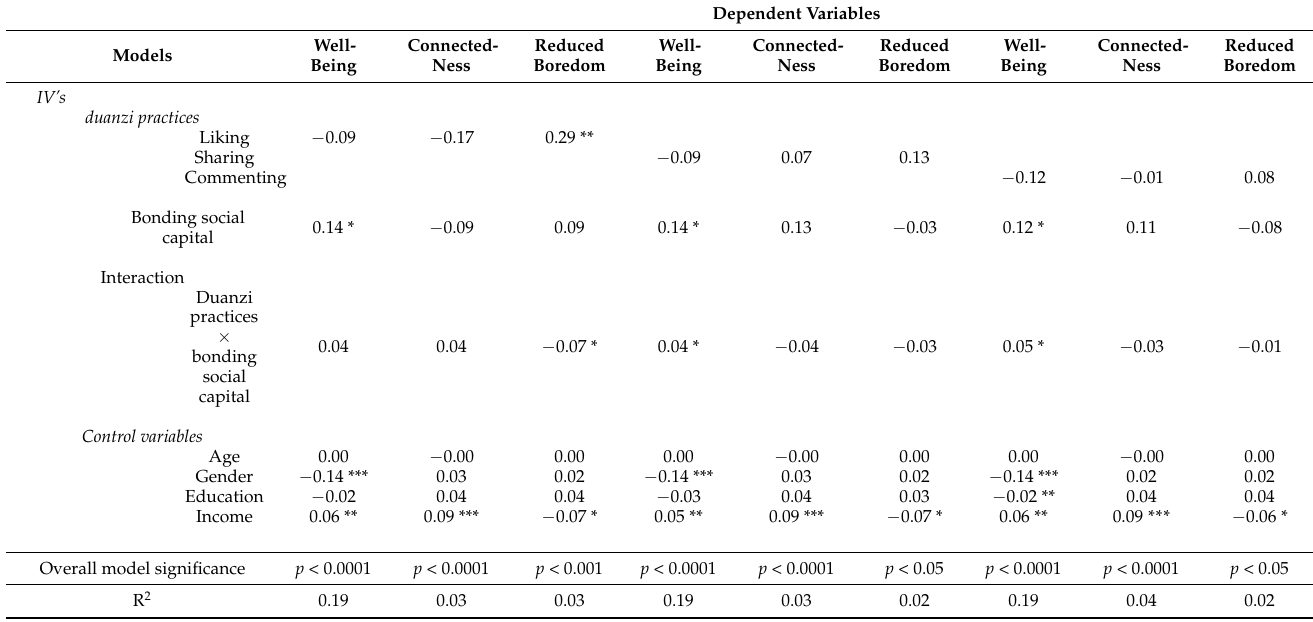
Table 2. Effect of duanzi practices by bonding social